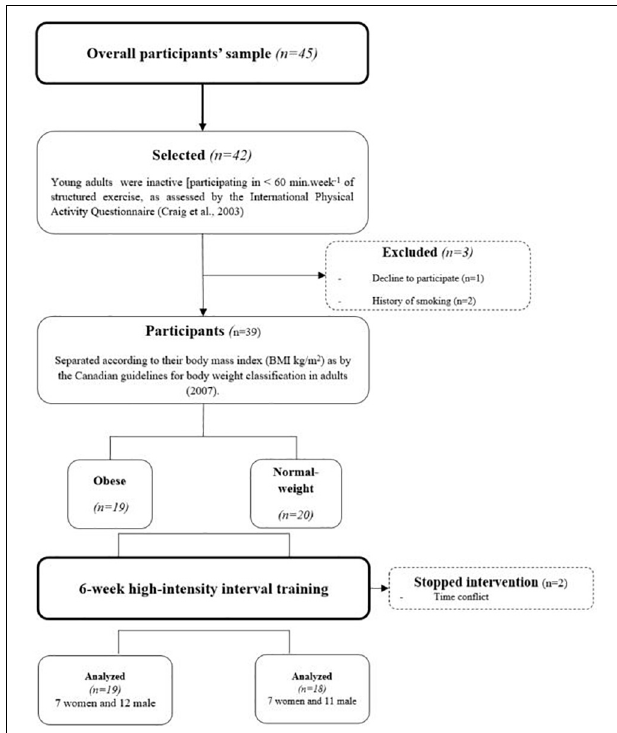
FIGURE 1 | Flowchart of participants’